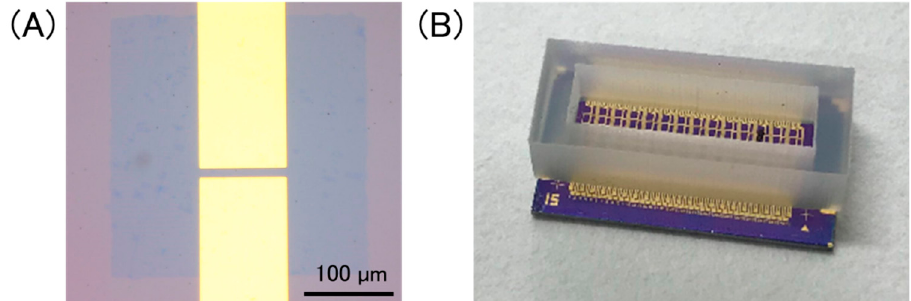
Figure 2. ( A ) Optical image of a GFET, in which a patterned graphene sheet is bridged between source/drain electrodes. Scale bar is 100 µ m; ( B ) a photo of a device chip. A silicone rubber container was set onto the chip to hold a solution on GFETs.